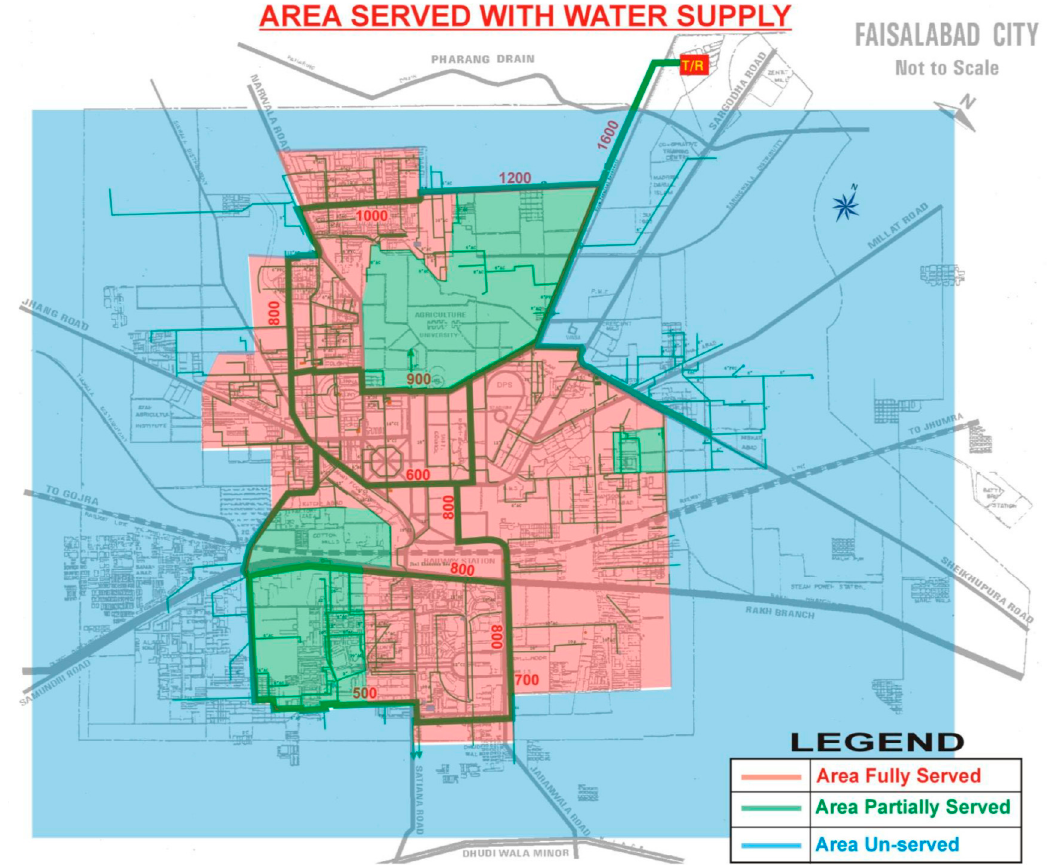
Figure 1. Water and Sanitation Authority (WASA) Water Supply Services Areas. Source: WASA Six-Year Business Plan (2014/15–2019/20).